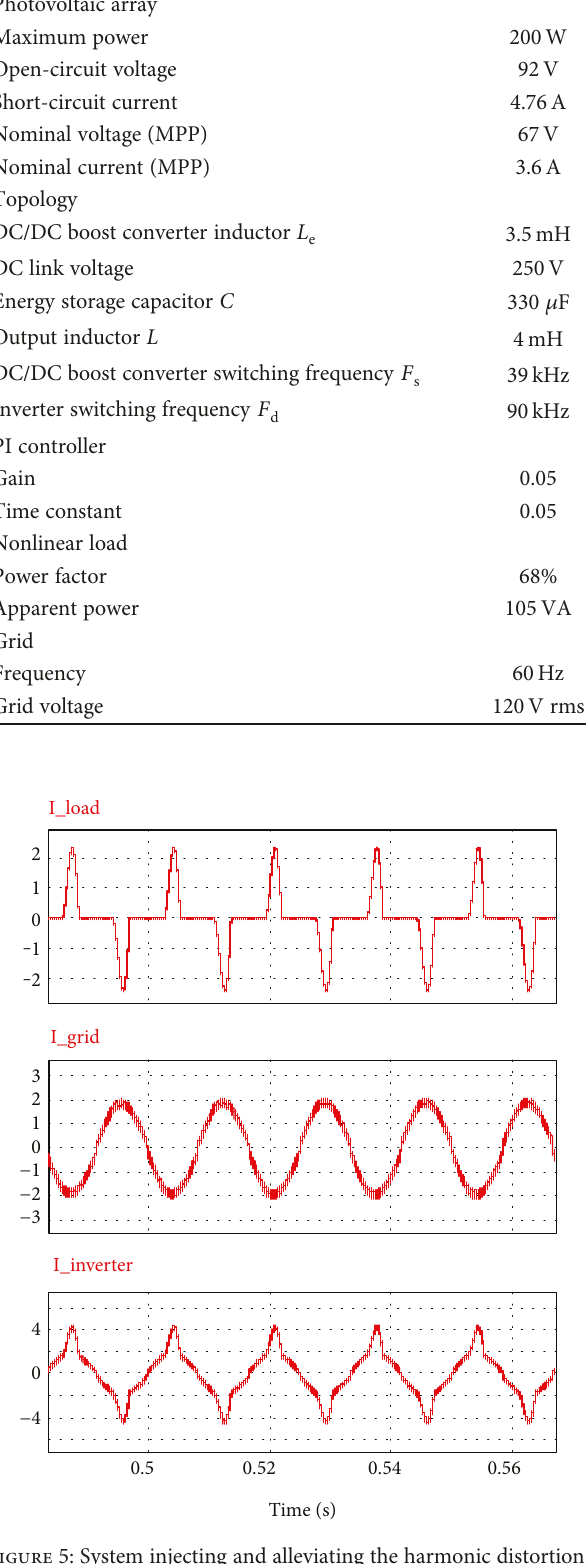
Figure 5: System injecting and alleviating the harmonic distortion. From (a) to (c): load current (1 A/div), grid current (1 A/div), and inverter current (2 A/div).